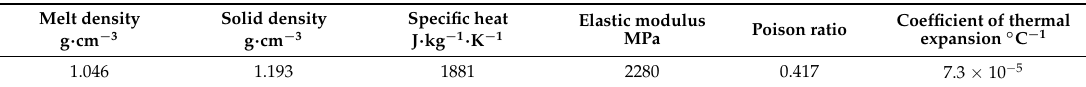
Figure 14. Geometry and finite element model of the car light cover. ( a ) Geometry; ( b ) Finite element model. Table 8. Basic properties of PC Lexan.